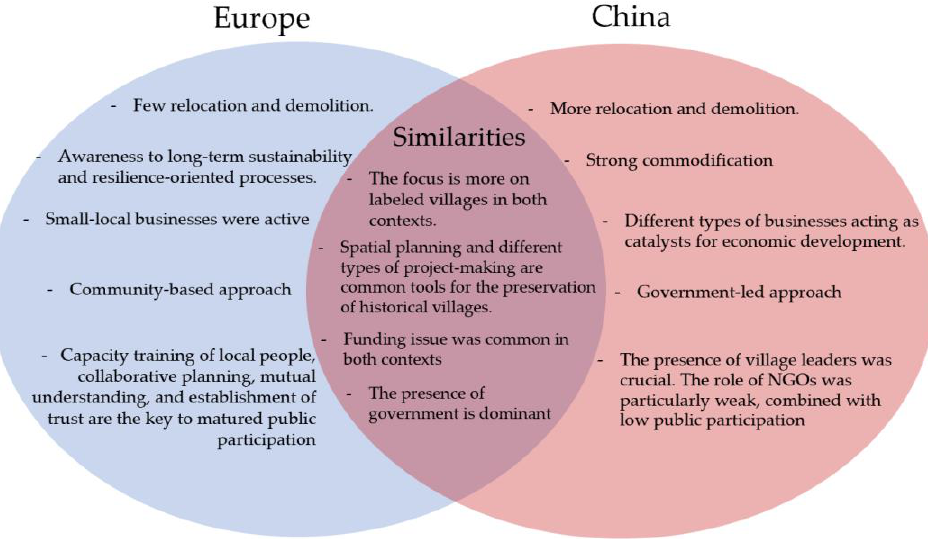
Figure 4. The similarities and differences of the case study villages in the two contexts. Author’s